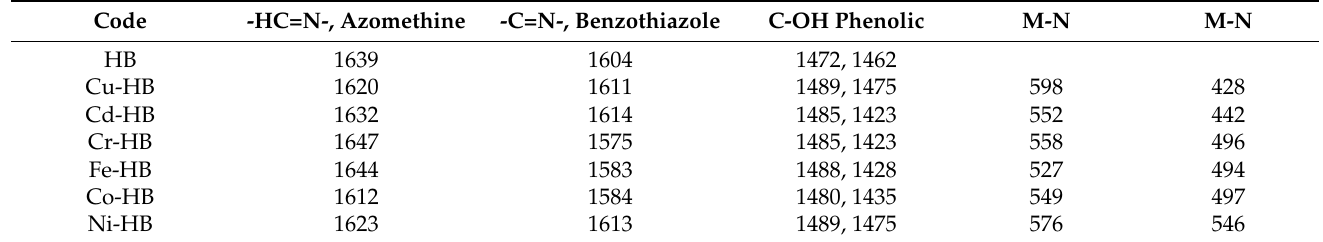
Table 4. FTIR main stretching absorption bands (cm − 1 ) of HB and its metal